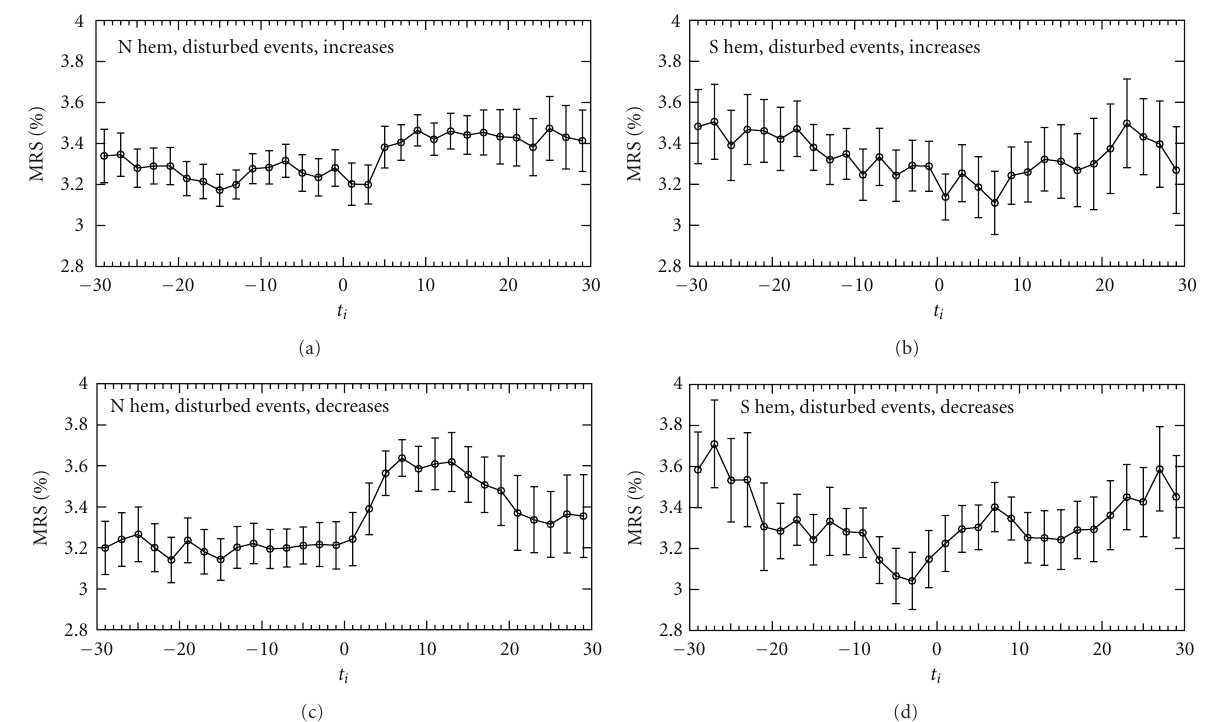
Figure 2: MRS as a function of the scan time, t i , for Disturbed events: (a) NH Is; (b) SH Is; (c) NH Ds; (d) SH